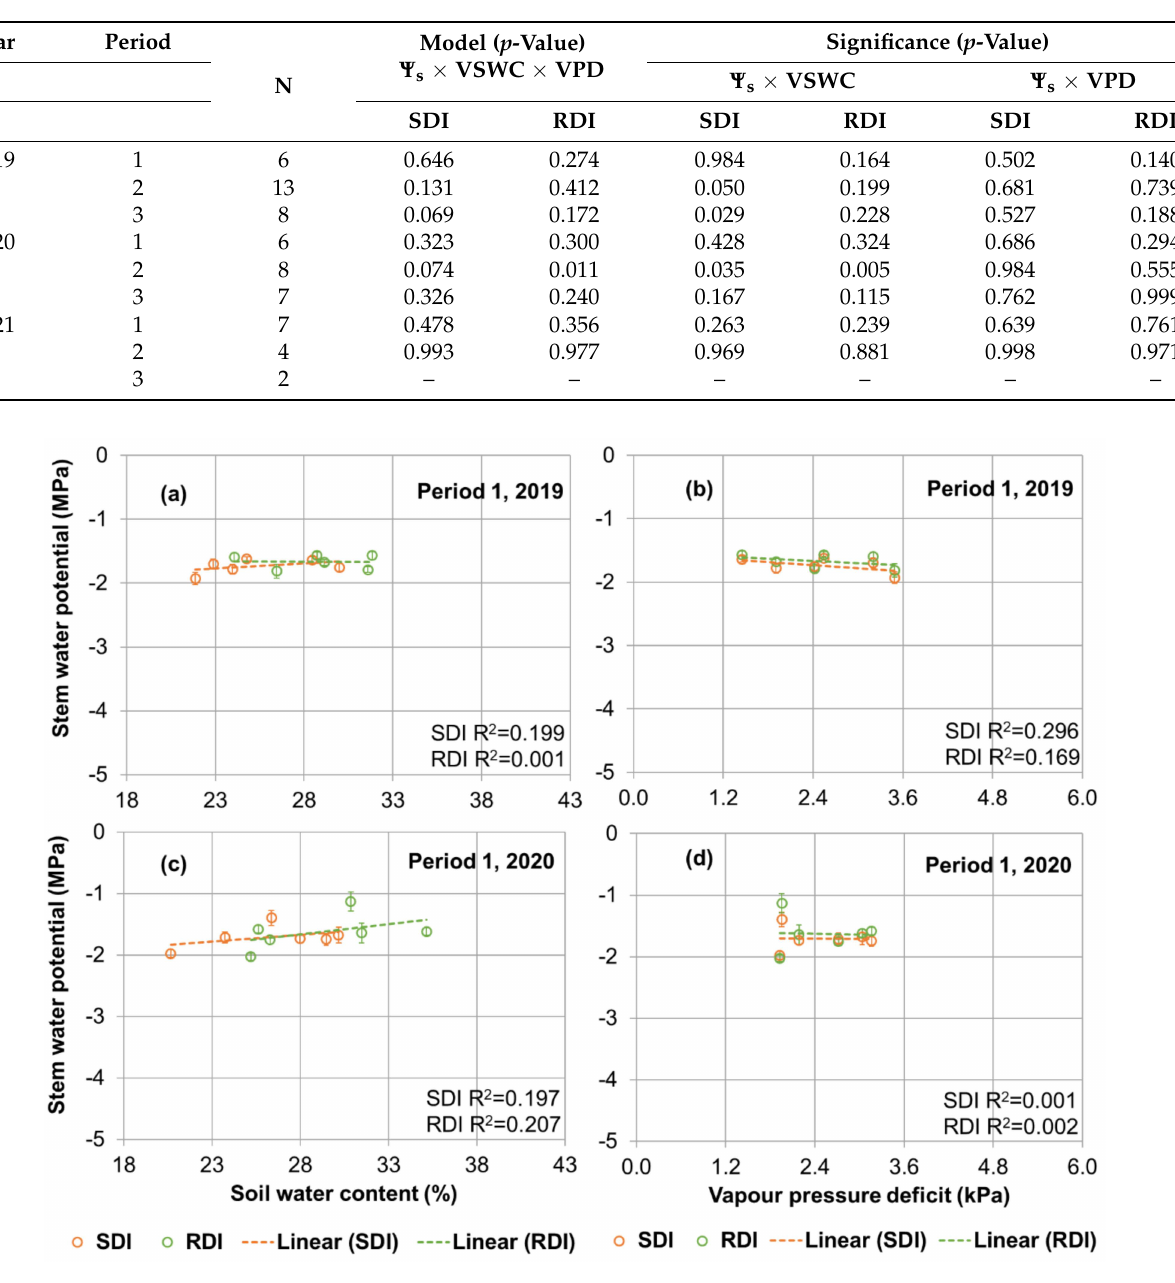
Table 5. Multiple linear regression analysis of the relation between Ψ s (average of five replicate plots per treatment) and volumetric soil water content (VSWC, of six trees in two replicate plots per treatment) and vapour pressure deficit (VPD) for three growth periods (see Table 1) and three years.